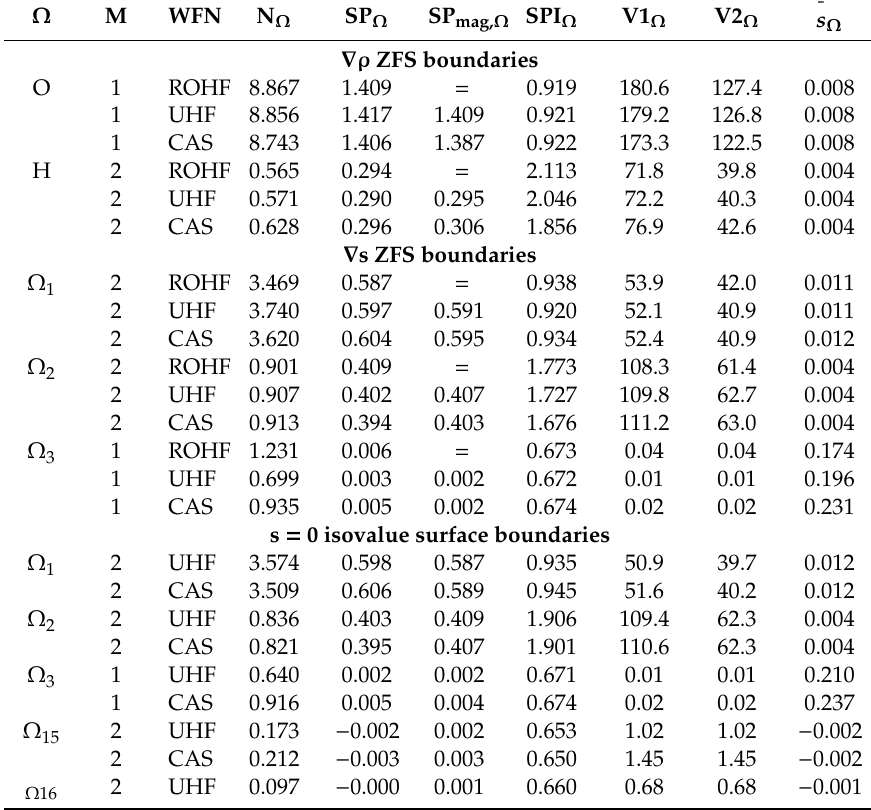
Table4. Basin Ω SelectedPropertiesofthe 3 B 1 H2Omoleculeforvarious Ω basintypesandwavefunction (WFN) models 1